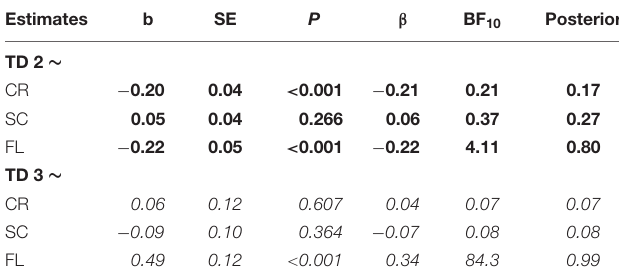
TABLE 3 | Regression estimates for all 3